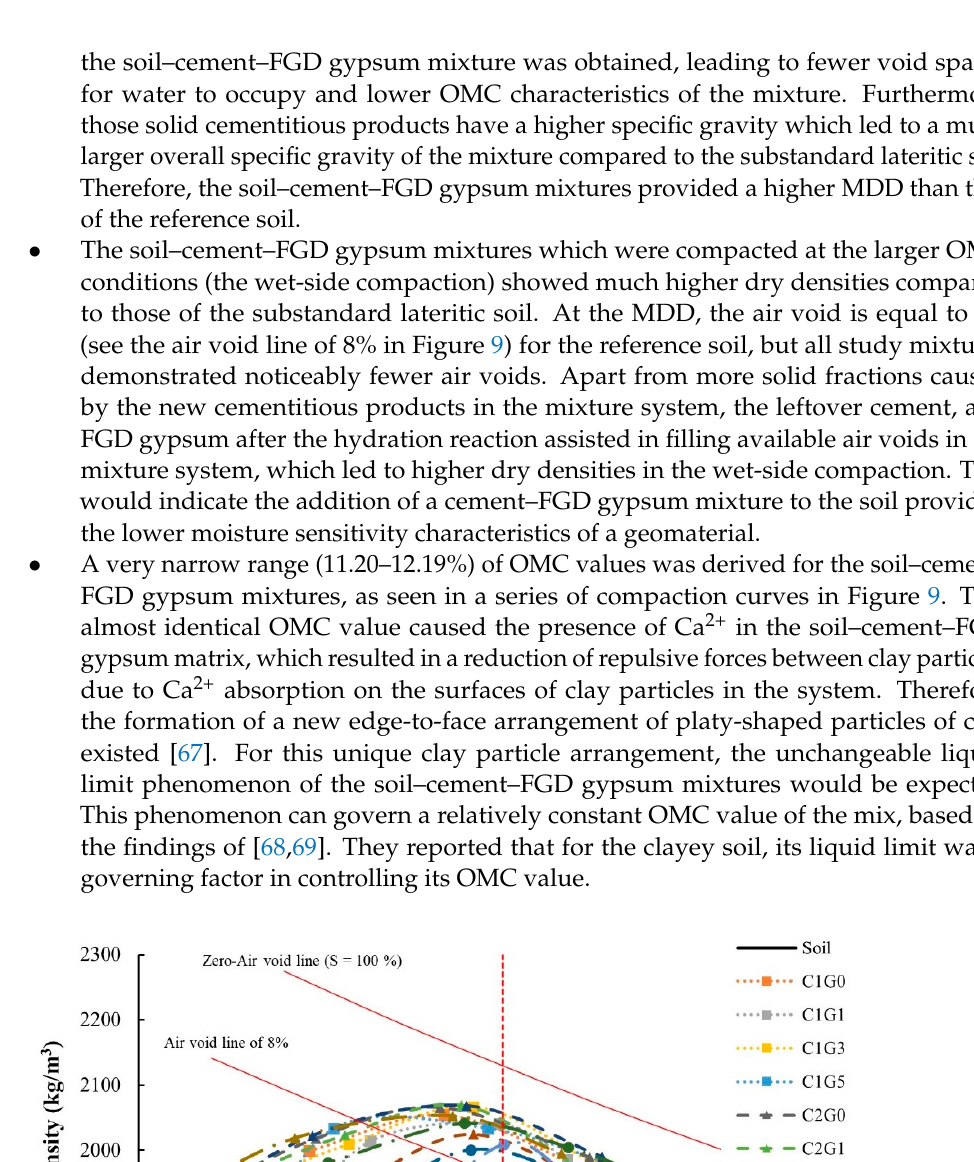
Table 6. Results of unconfined compression strength test and CBR test.